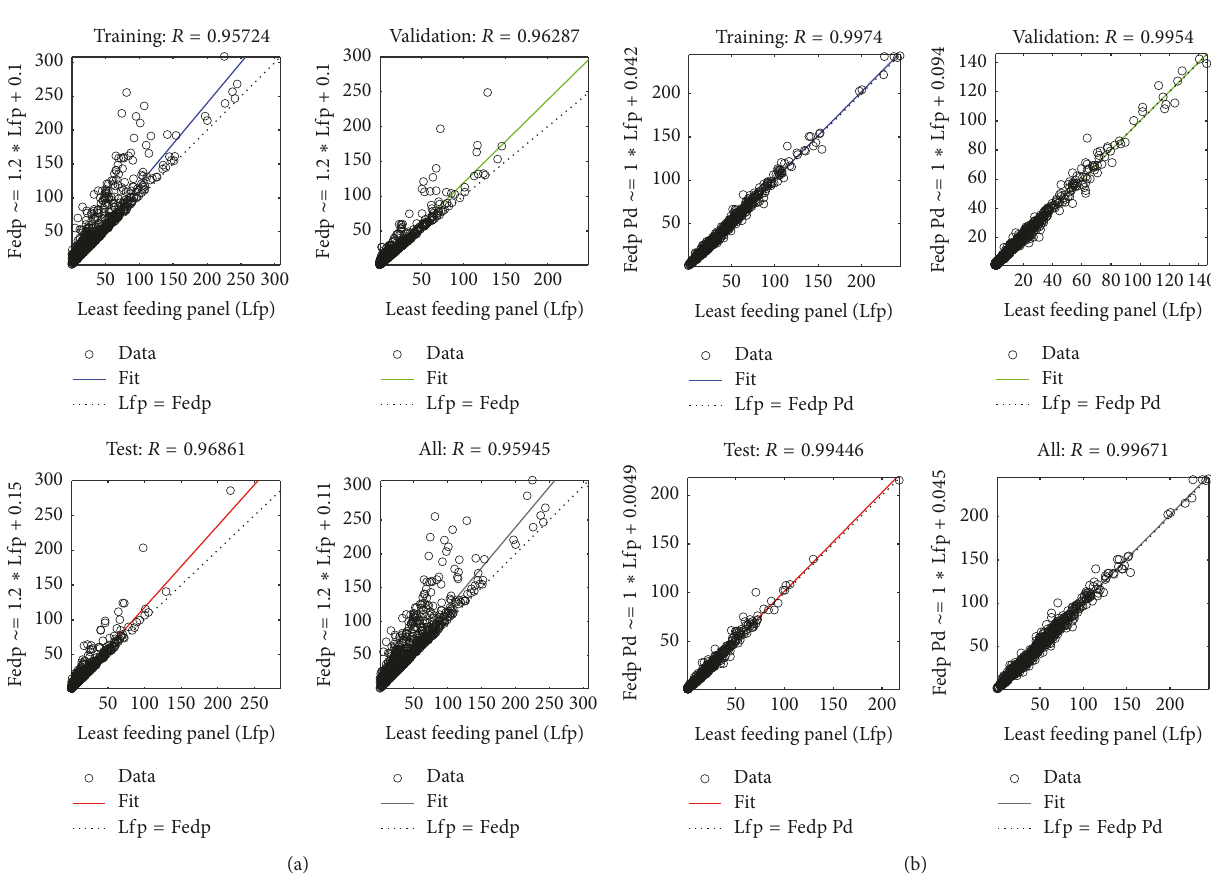
Figure 12: (a) Regression of manual feeding panel versus least feeding panel. (b) Regression of predicted feeding panel versus least feeding